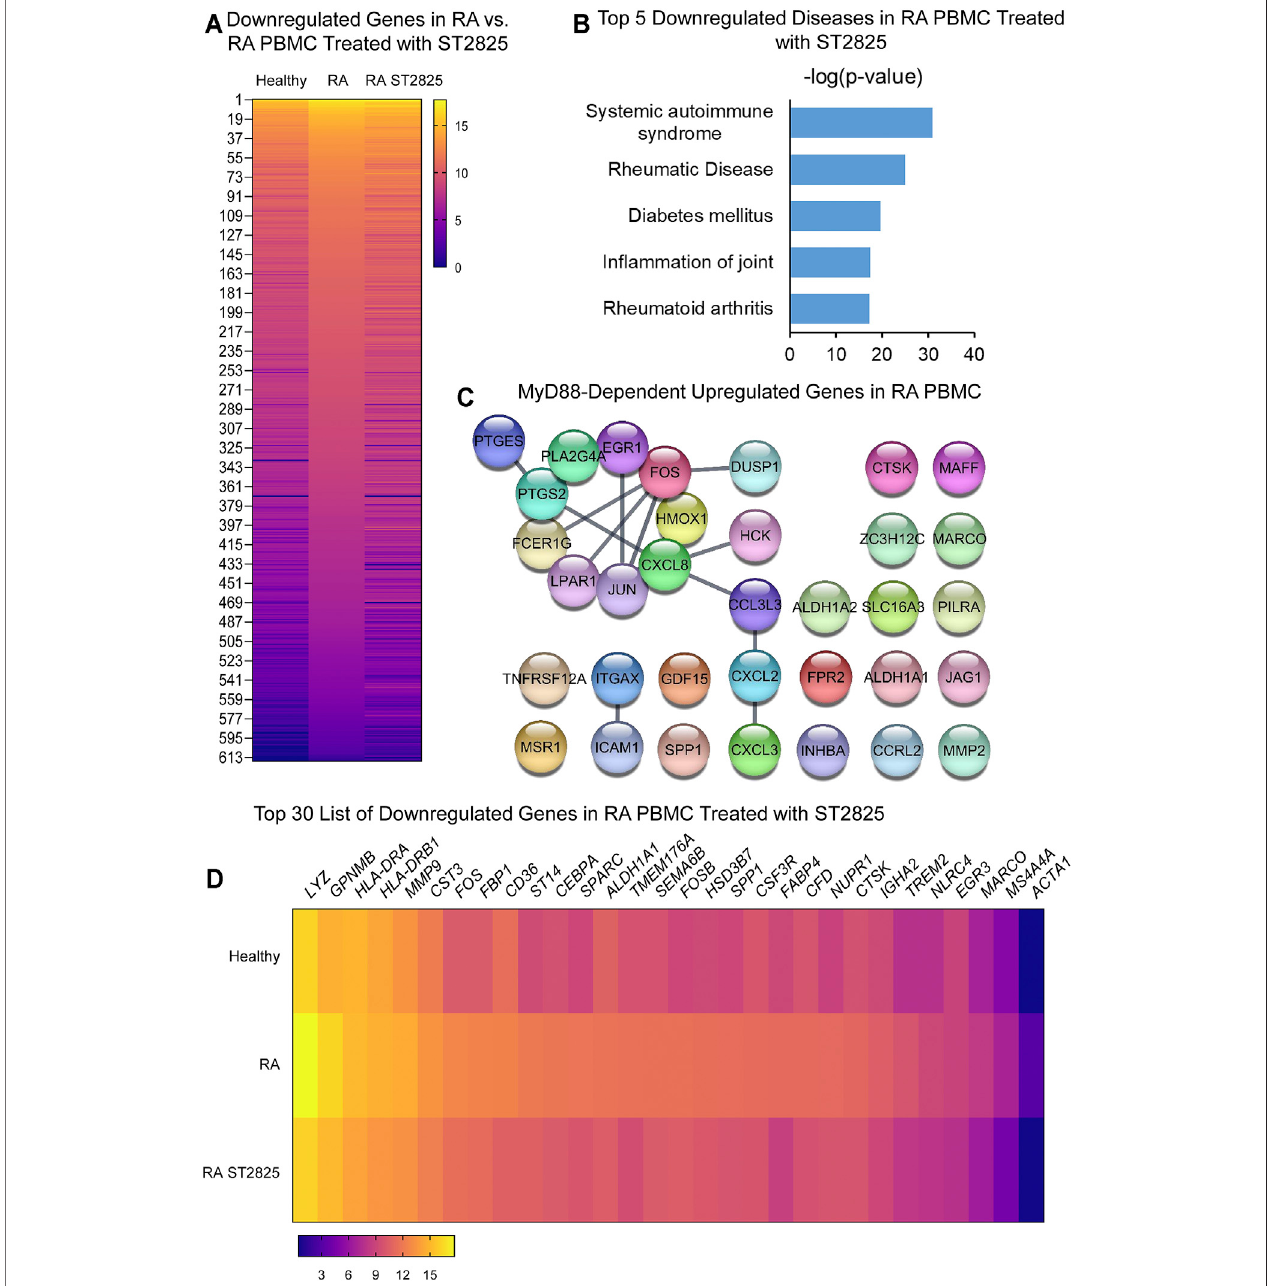
FIGURE 2 | MyD88 inhibition by ST2825 downregulates critical molecules and IPA-predicted disease associations in PBMC from DMARDs-naïve RA patients. (A) Transcriptomicsignaturesfromhealthysubjects,RAandRAPBMCtreatedwithST2825areshownintheheatmap(averagedexpressionpatternsofbiologicalreplicates are shown). (B) MyD88-predicted target gene network was identi fi ed from upregulated genes expressed in RA PBMC vs. healthy subjects. (C) Top 5 of IPA-predicted disease associations were determined based on downregulated genes by effect of ST2825. (D) Top 30 downregulated genes by effect of ST2825 involved in the in fl ammatory response are illustrated in the heatmap (averaged expression patterns of biological replicates are shown).